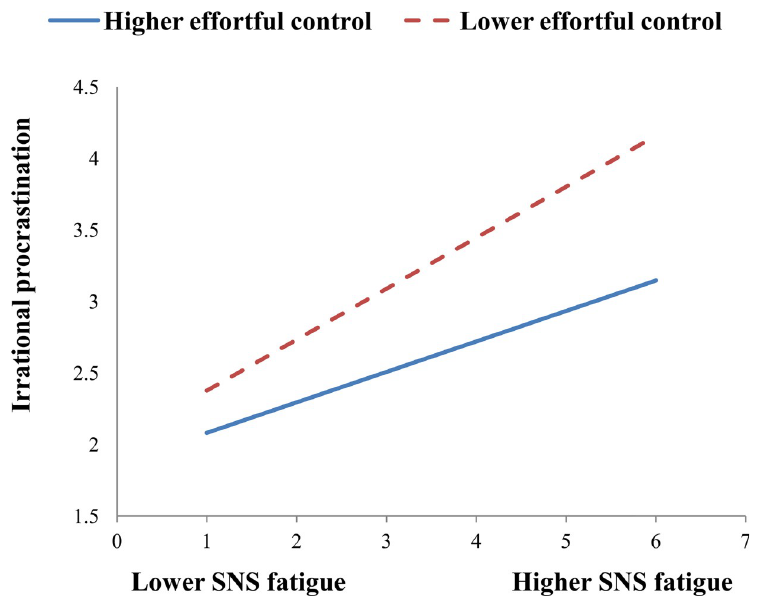
Fig 4. Effortful control moderates the relation between SNS fatigue and irrational